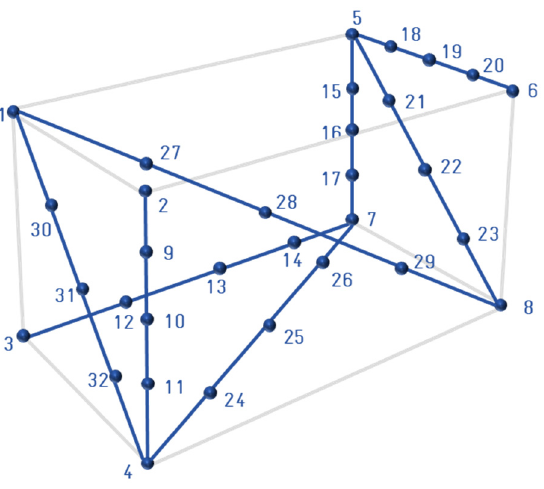
Figure 10. Positions of the bar to verify the accuracy of Optical 3D measuring systems following VDI-VDE 2634.